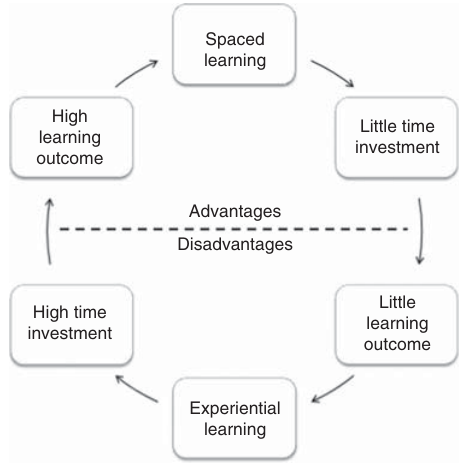
Figure 8. Advantages